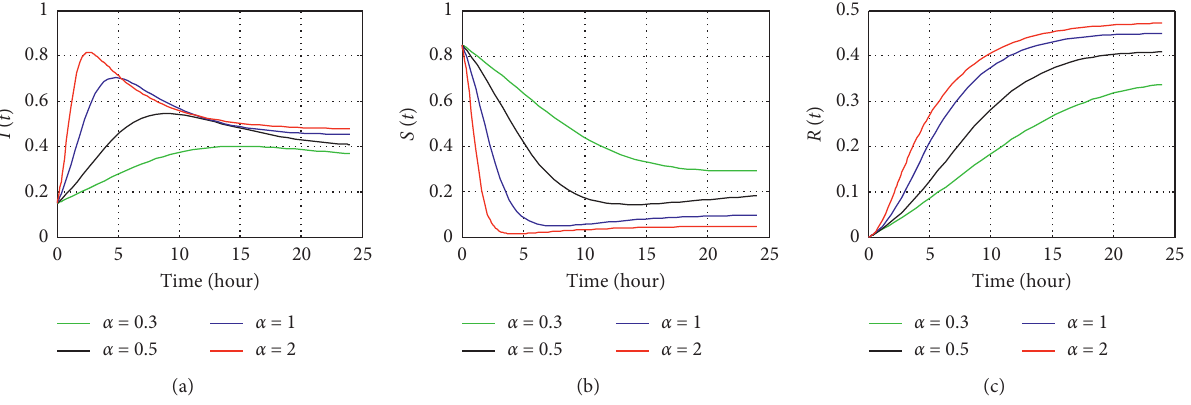
Figure 6: I ( t ) , S ( t ) , and R ( t ) under different α .